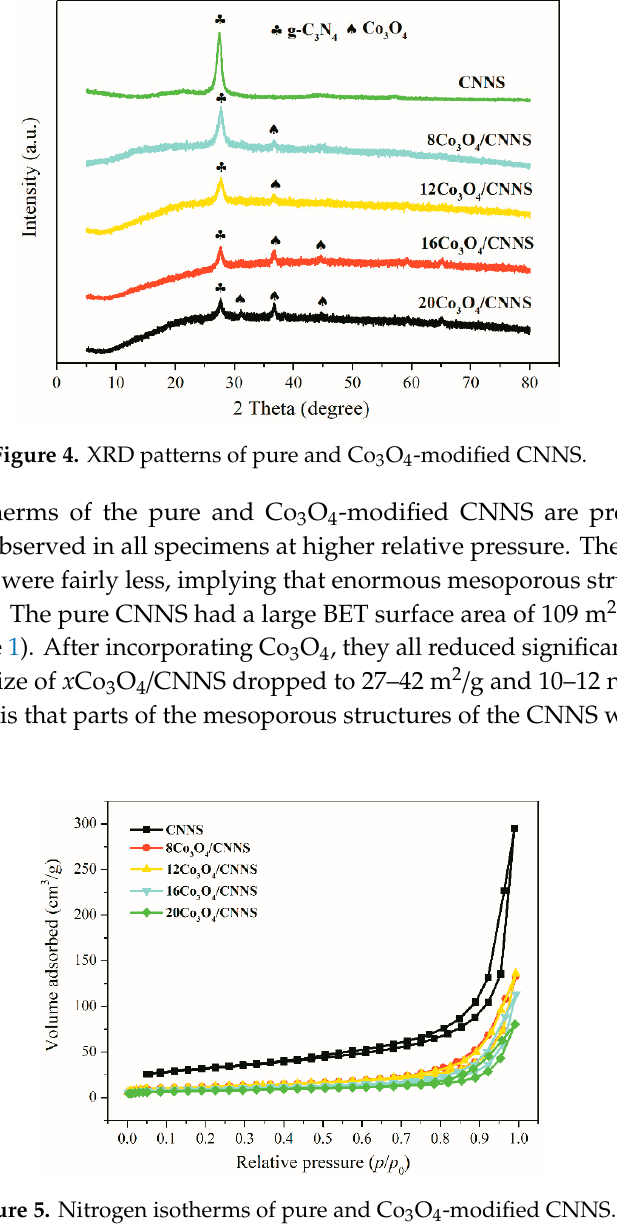
Figure 5. Nitrogen isotherms of pure and Co 3 O 4 -modified CNNS.